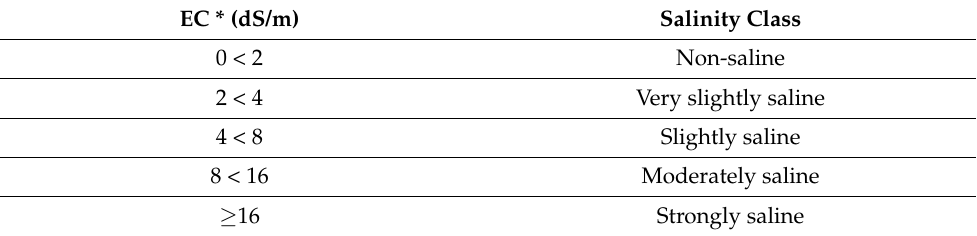
Table 1. Classes of salinity and EC (1 dS/m = 1 mmhos/cm; adapted from NRCS Soil Survey Handbook).